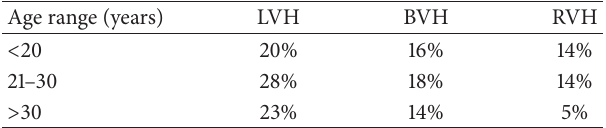
Table 3: ECG abnormalities by age in SCD.